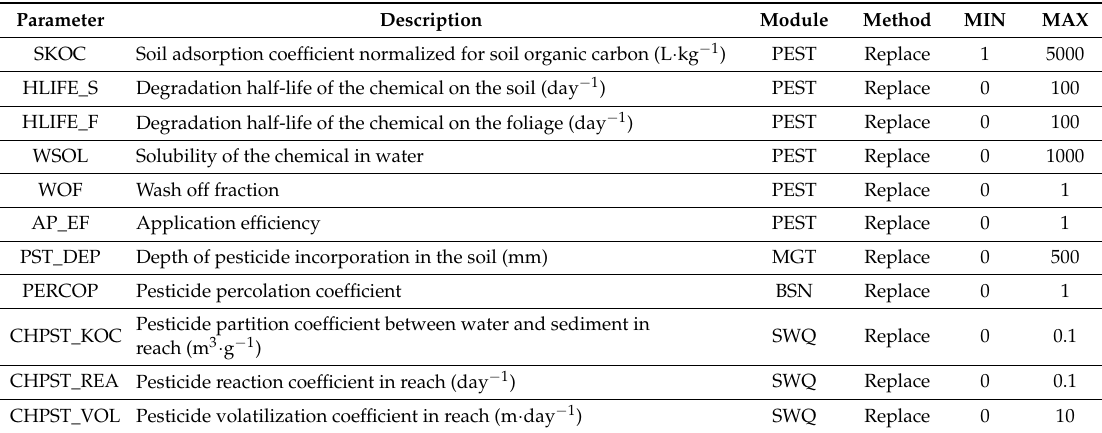
Figure 2. Original SWAT model applies the two-phase partitioning approach: pesticide in liquid phase and pesticide sorbed to the solid phase. Modified pesticide model assumes the three-phase partitioning model: dissolved pesticide, particle-bound pesticide, and DOC-associated pesticide. Table 3. Pesticide parameters for calibration and sensitivity analysis of the original SWAT model.